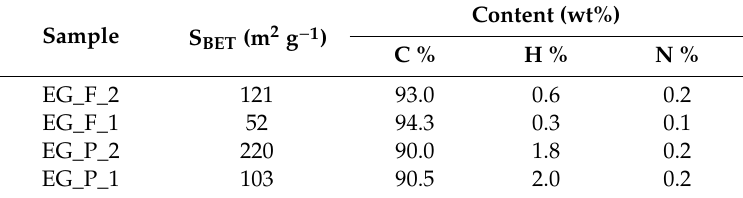
Table 2. Specific surface area (S BET ) and elemental content of carbon, hydrogen, and nitrogen.